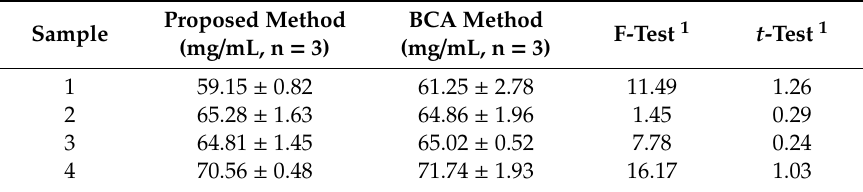
Table 3. The results of serum total protein.